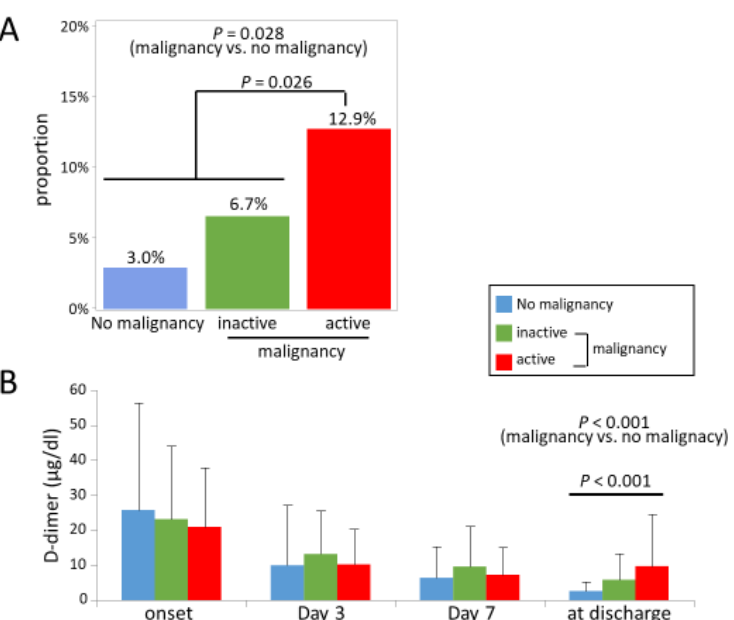
Figure 3. ( A ) The percentage of patients who did not show the regression of thrombus on CT and ( B ) the time course changes of D-dimer during the treatment. ( A ) The percentage of patients who did not show the regression of thrombus was significantly higher in the malignancy group than in the no ‐ malignancy group. CT, computed tomography. Table 3. Multiple regression analysis for D ‐ dimer level at discharge.